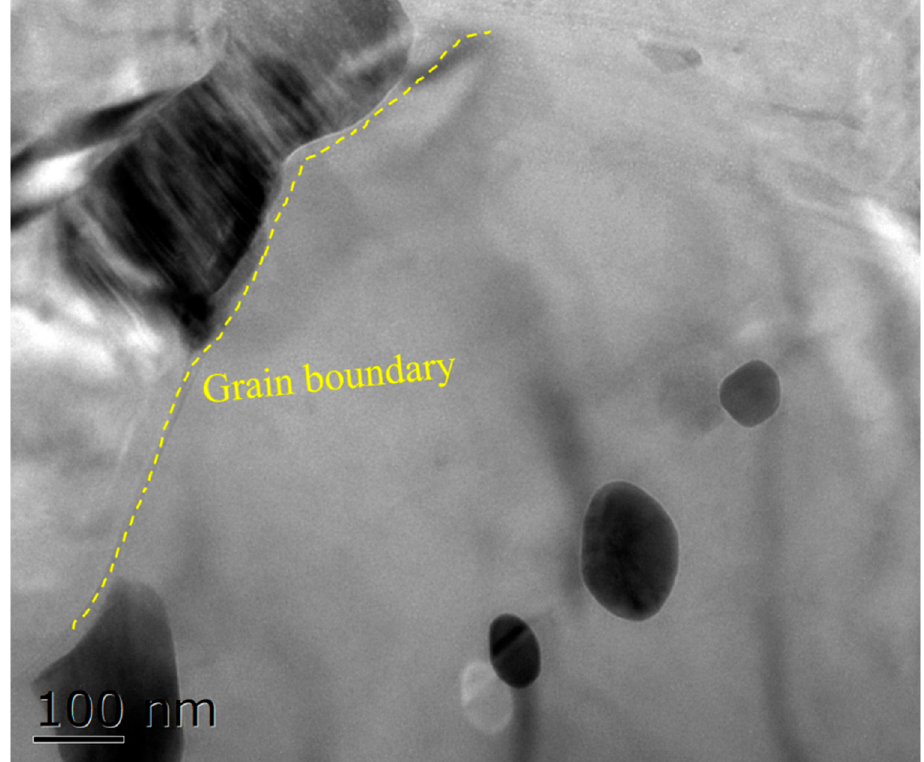
Figure 15. TEM microstructure of the SiC p /Mg-5Zn material with a compression strain of 0.35.